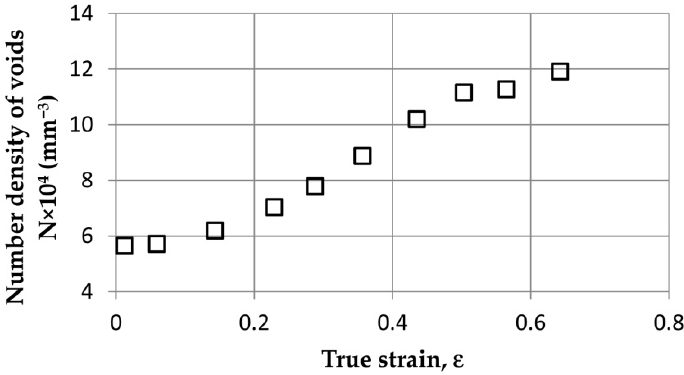
Figure 7. Experimentally determined relation between density of voids and plastic strain in JIS SUM24L free ‐ cutting steel, from [54].